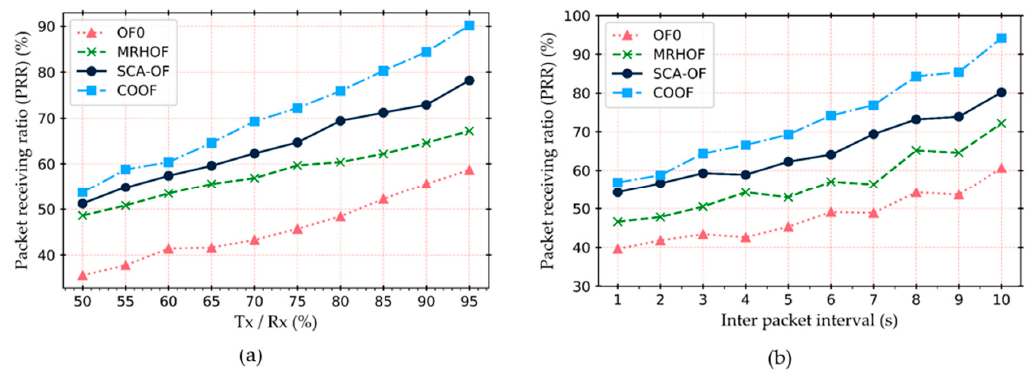
Figure 10. Packet reception ratio on DODAG root; ( a ) PRR with respect to the transmit success and receive success ratio, ( b ) PRR with respect to the inter packet interval.